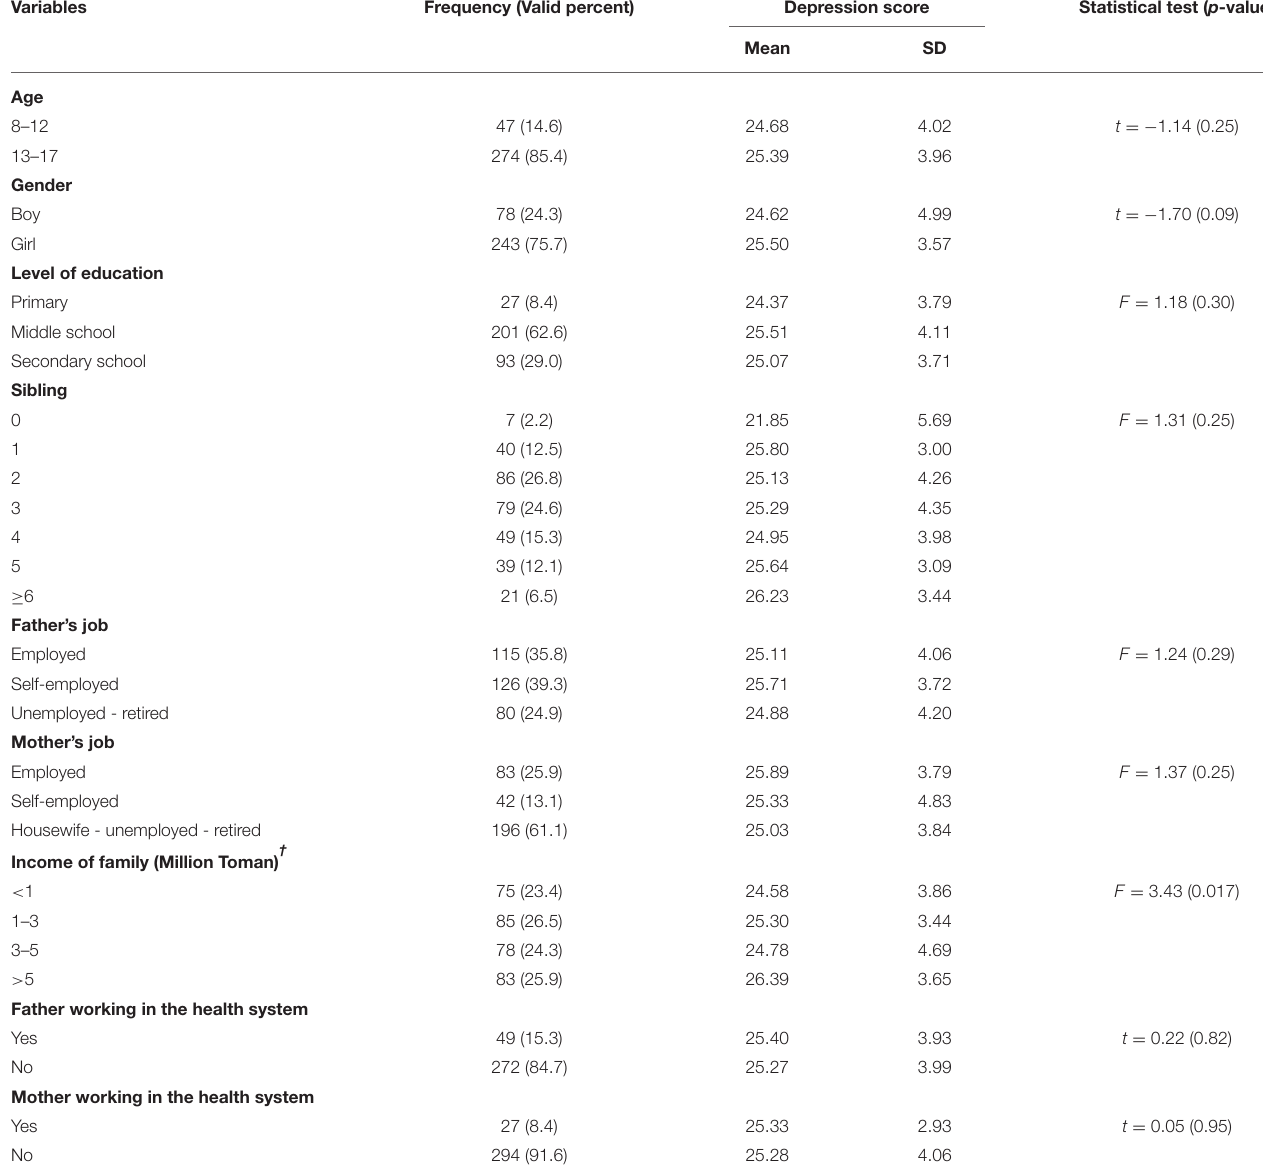
TABLE 1 | Demographic characteristics of the participants and their associations with depression ( n =